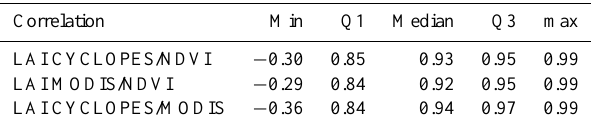
Table 2. Statistics of comparison between SPOT/VGT NDVI and MODIS LAI for the temporal profiles averaged for all ECOCLIMAP-II land covers. 25% of correlations are higher than the value for Q1; 50% are higher than the median value; 75% are higher than the Q3